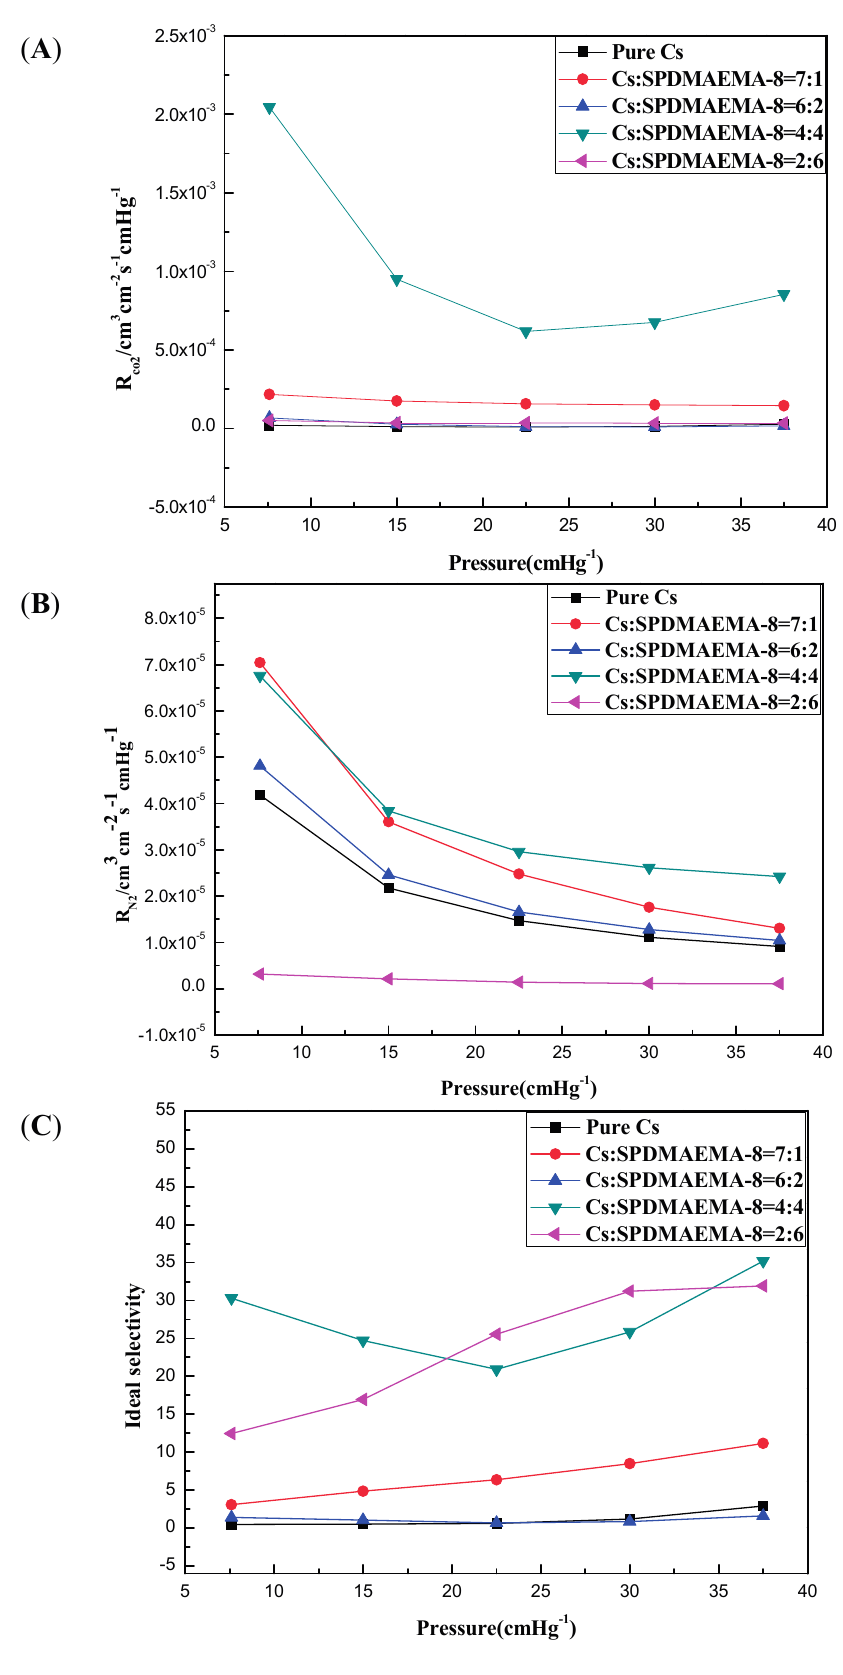
Figure 8. The permeability of the blinding composite membranes at different Cs/SPDMAEMA-8 volume ratios ( A ) CO 2 permeation rate ( B ) N 2 permeation rate ( C ) Ideal Selectivity of CO 2 over N 2 (Pure humidified gas, 30